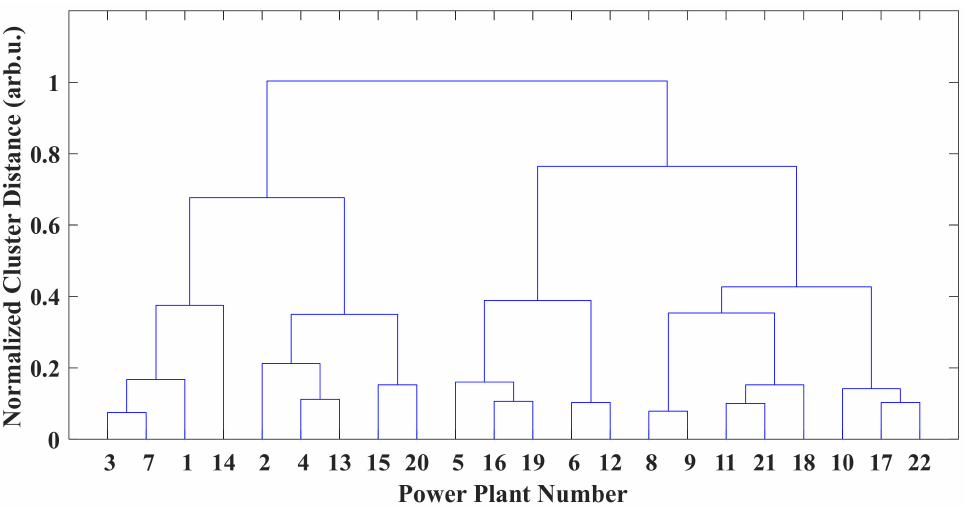
Figure 7. Cluster process of sub-region division.